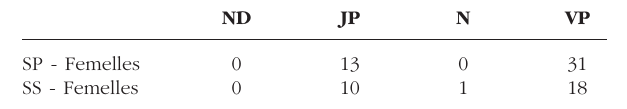
Tableau V. – Nombre d’infection et âge physiologique des